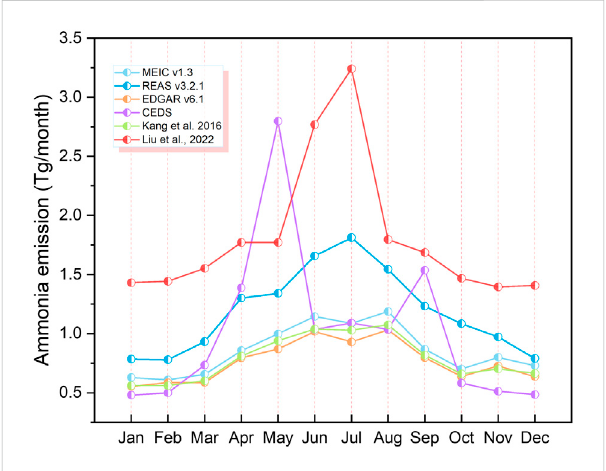
The seasonal variations of NH 3 emissions (Tg/month) in China from six different studies. (Monthly emissions were collected from the most recent year available for each dataset).